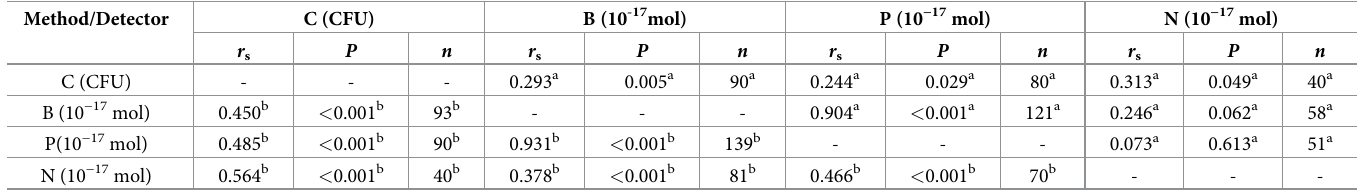
Table 3. Correlationbetween different method/detector to determine the CFU and ATP content (per surface site), using the Spearman rank correlation coefficients ( r s